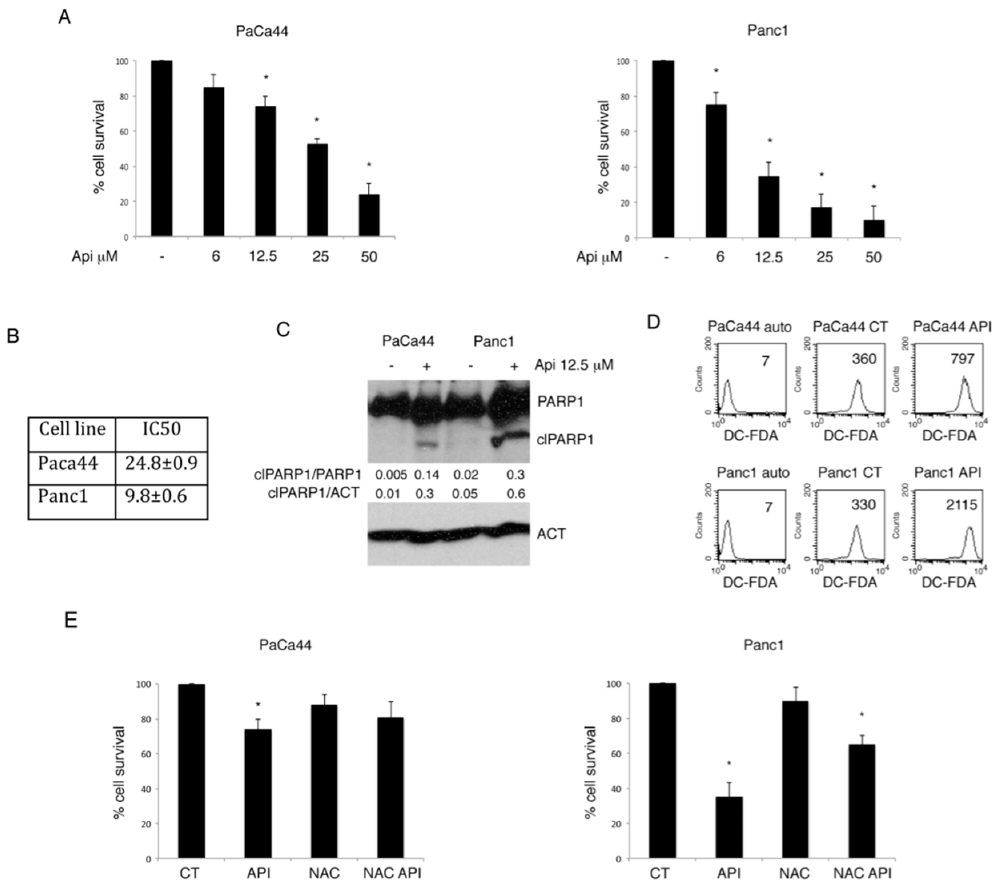
Figure 1. Apigenin-induced cell death is dose-dependent and correlates with reactive oxygen species (ROS) production. ( A ) Viability of PaCa44 and Panc1 treated with di ff erent doses of Apigenin (6, (ROS) production. ( A ) Viability of PaCa44 and Panc1 treated with different doses of Apigenin (6, 12.5, 25, and 50 μ M) or untreated for 24 h was evaluated by trypan blue exclusion assay. Mean plus SD of